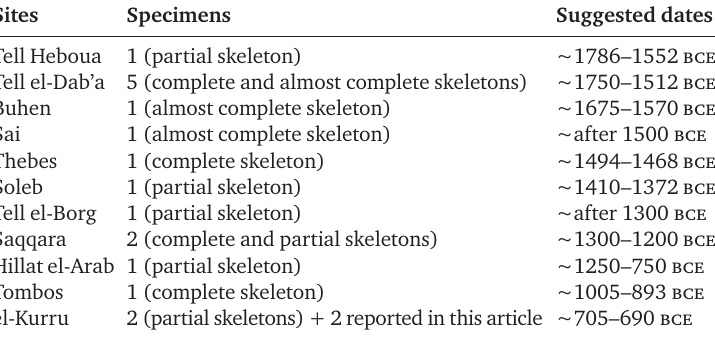
Table 1 List of published horse specimens from Egypt and Nubia. (Data compiled from Turner 2015, Schrader et al. 2018 and Ikram 2019; all dates are quoted from these publications or the primary excavation and zooarchaeologi- cal reports referenced in them and are based on archaeological context, except in the case of the Tombos horse for which a 14C date was obtained from linen fabric adhering to the body, see Schrader et al. 2018,